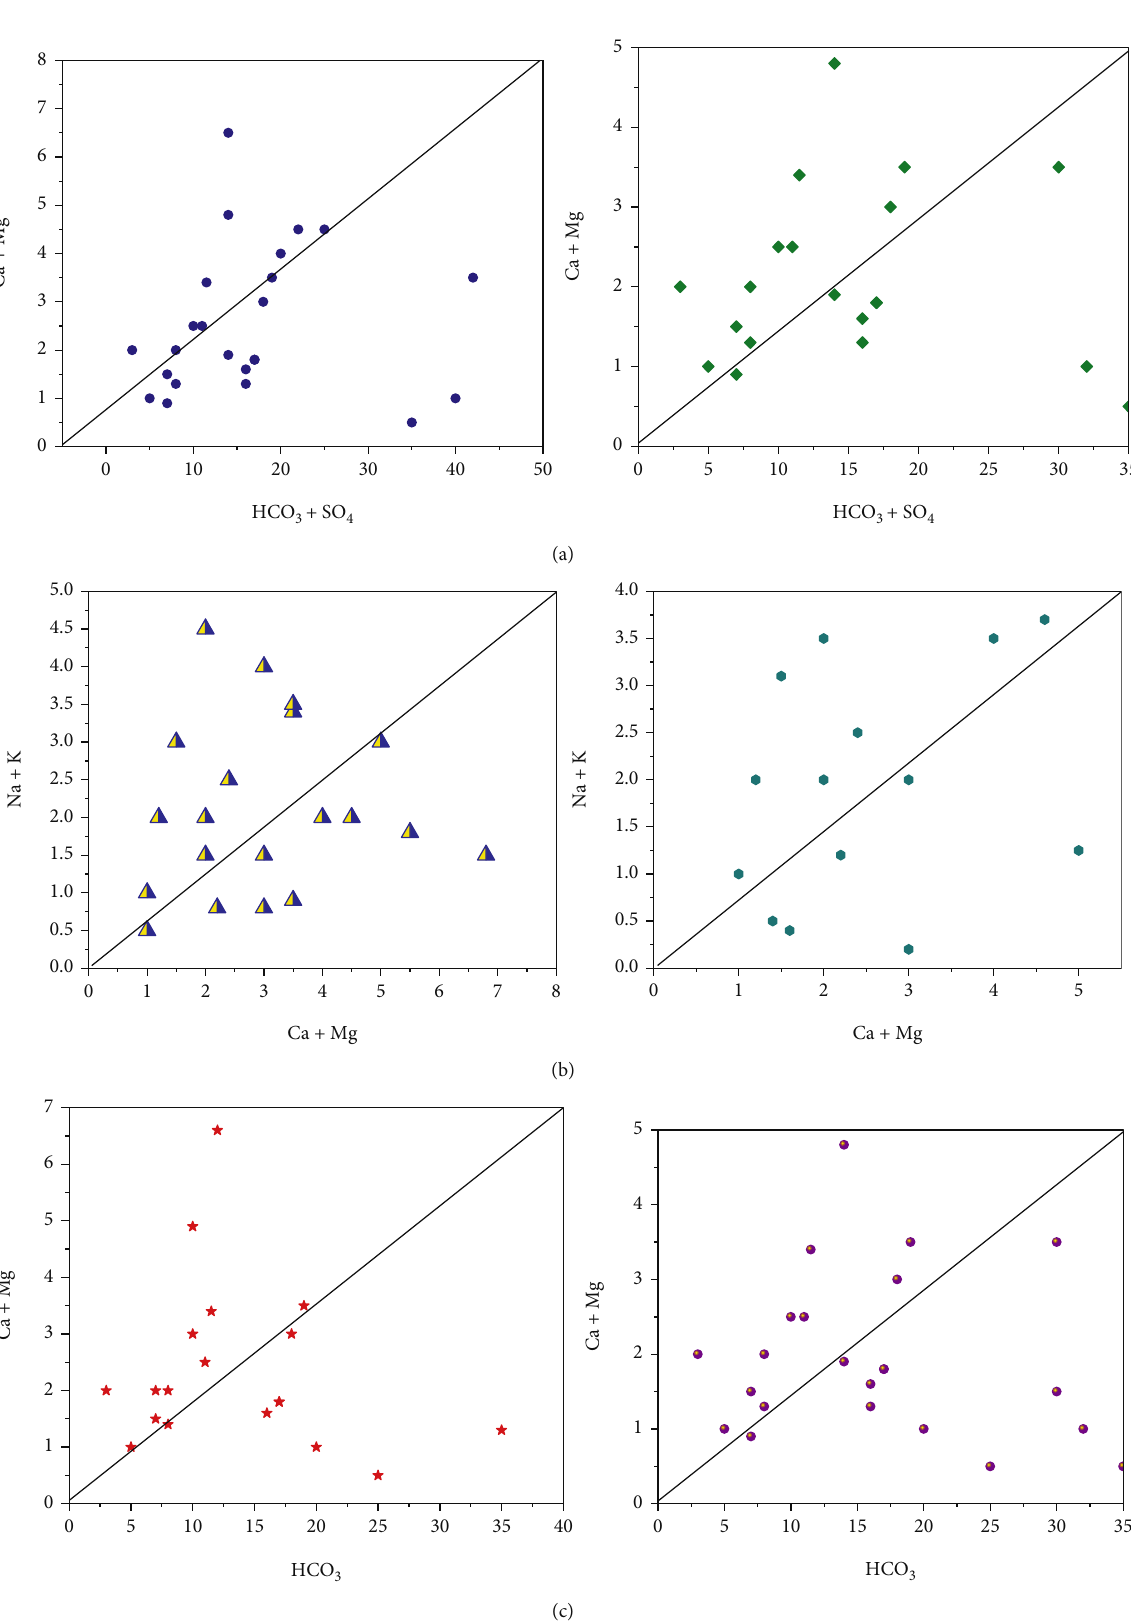
+ SO vs : Ca + Mg . (b) Ca + Mgvs : Na + K . (c) HCO 3 4